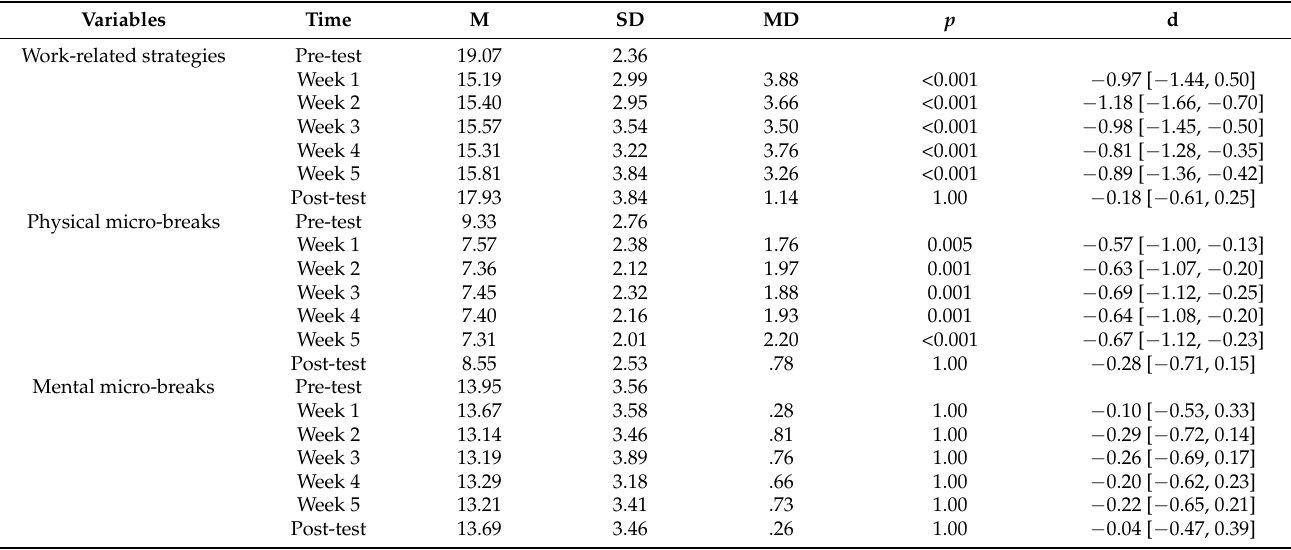
Table 5. Post hoc comparison between measurement moments of work-related strategies and micro- breaks (i.e., physical, mental) at the pre-test versus self-monitoring moments and post-test within the experimental group.